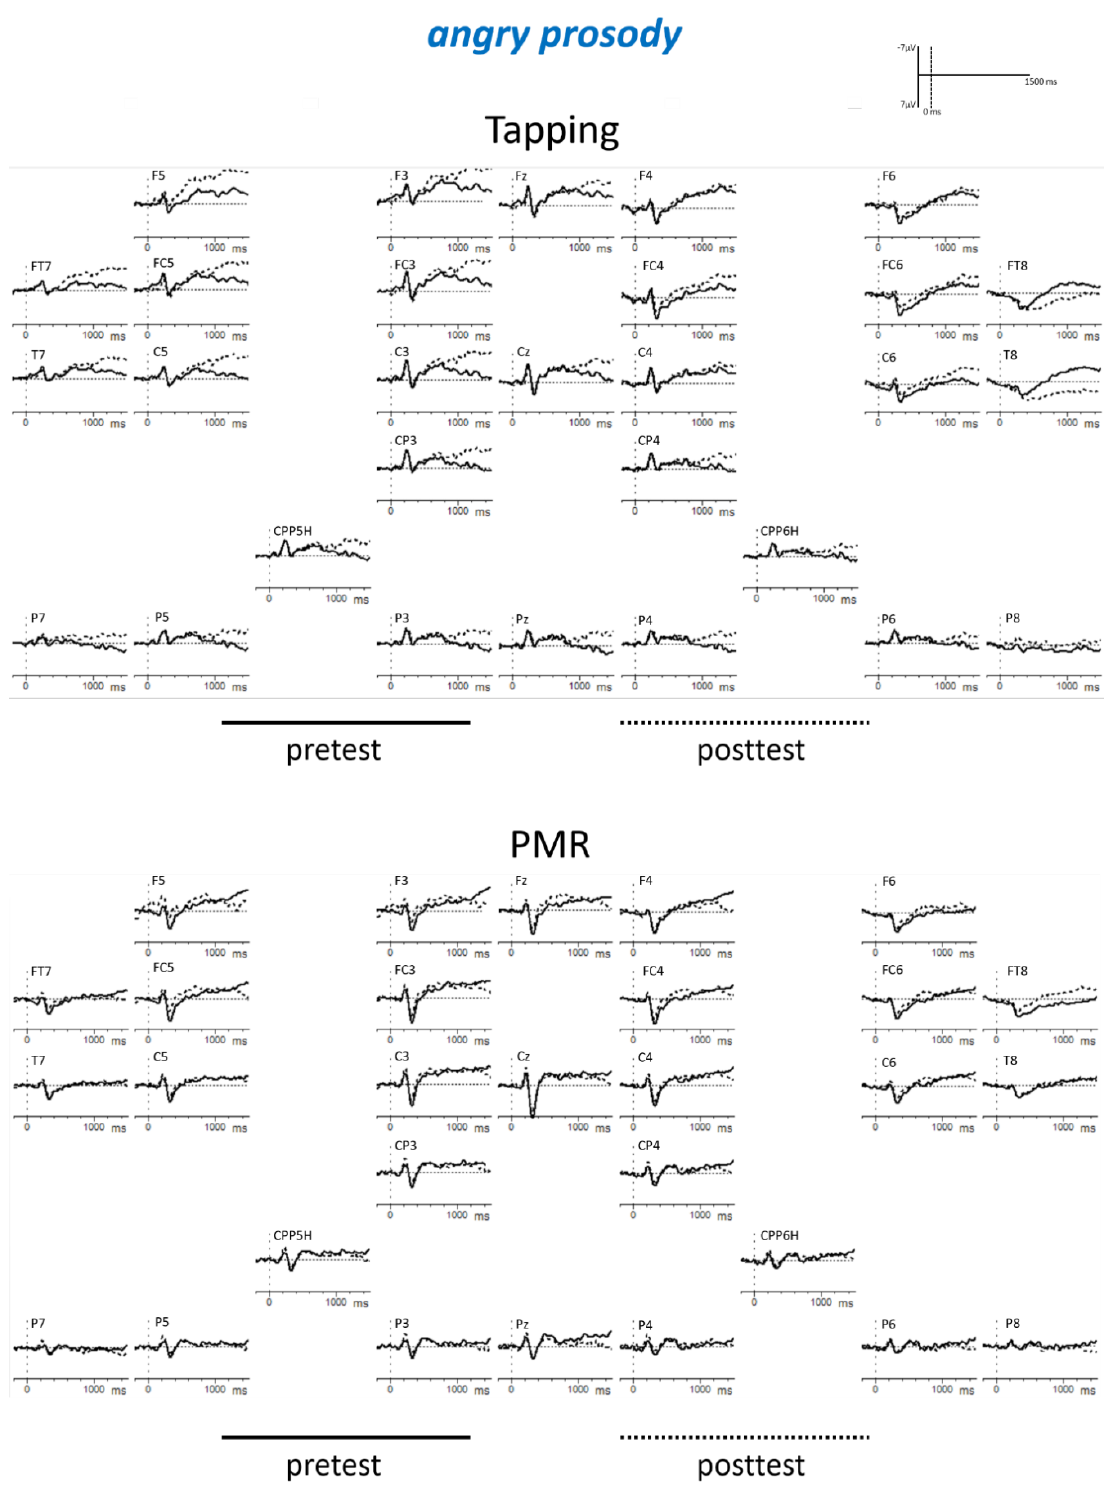
Figure A3. EEG results for all electrodes when processing angry prosody. Positive polarity is plotted downwards.